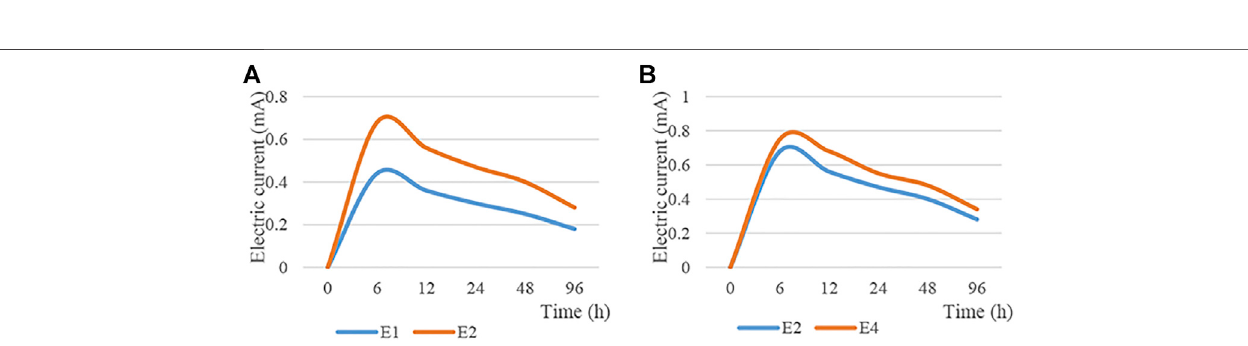
Frontiers in Energy Research |